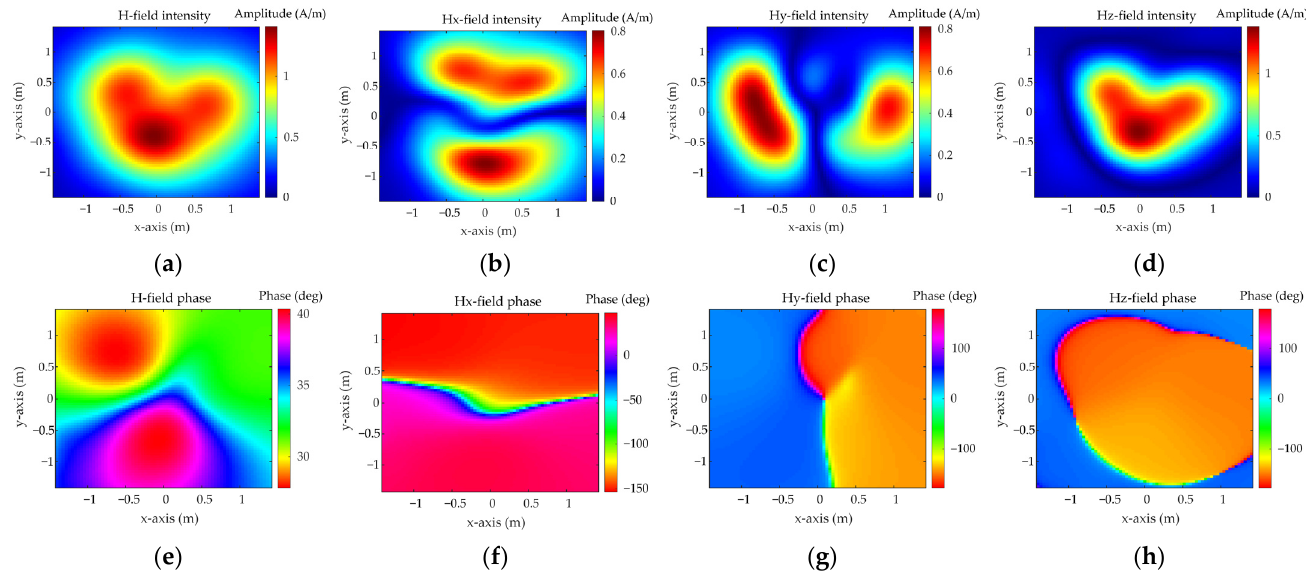
Figure 14. The distribution of the magnetic field calculated by the equivalent magnetic dipole array. ( a ) The amplitude distribution of H; ( b ) The amplitude distribution of Hx; ( c ) The amplitude distribution of Hy; ( d ) The amplitude distribution of Hz; ( e ) The phase distribution of H; ( f ) The phase distribution of Hx; ( g ) The phase distribution of Hy; ( h ) The phase distribution of Hz. Table 4. Relative errors of magnetic field obtained by method of this